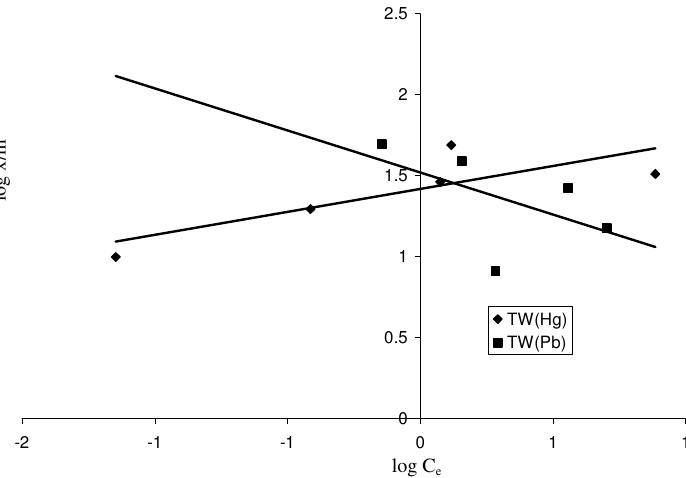
Figure 10 . Freundlich adsorption isotherm in tap